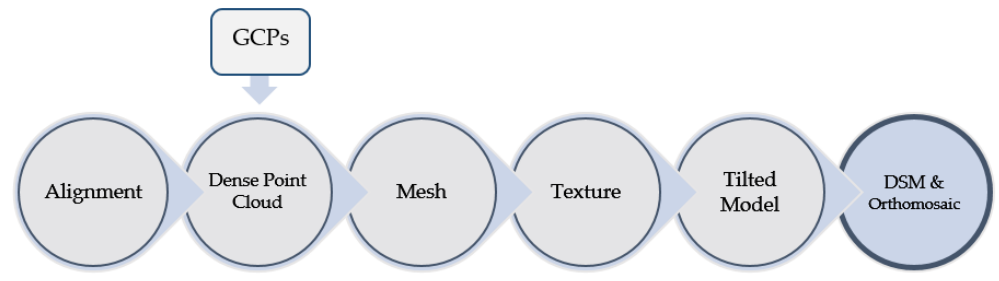
Figure 2. Photogrammetric processing workflow.